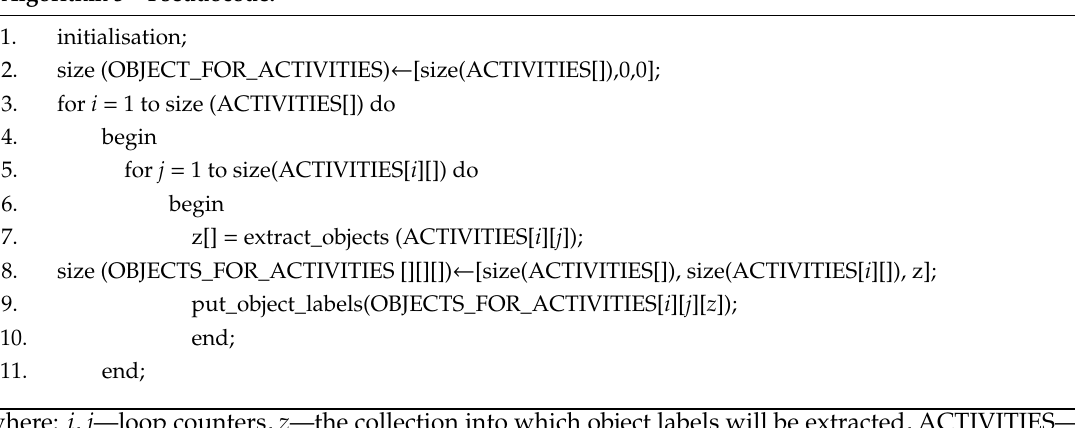
Algorithm 4: Algorithm comparing the features and objects of the test material frames with the previously created database of actions (and their features and